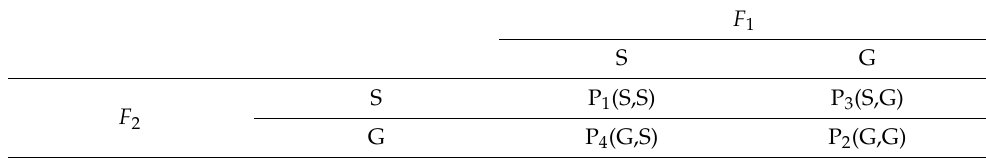
Table 1. Game strategy player combinations.